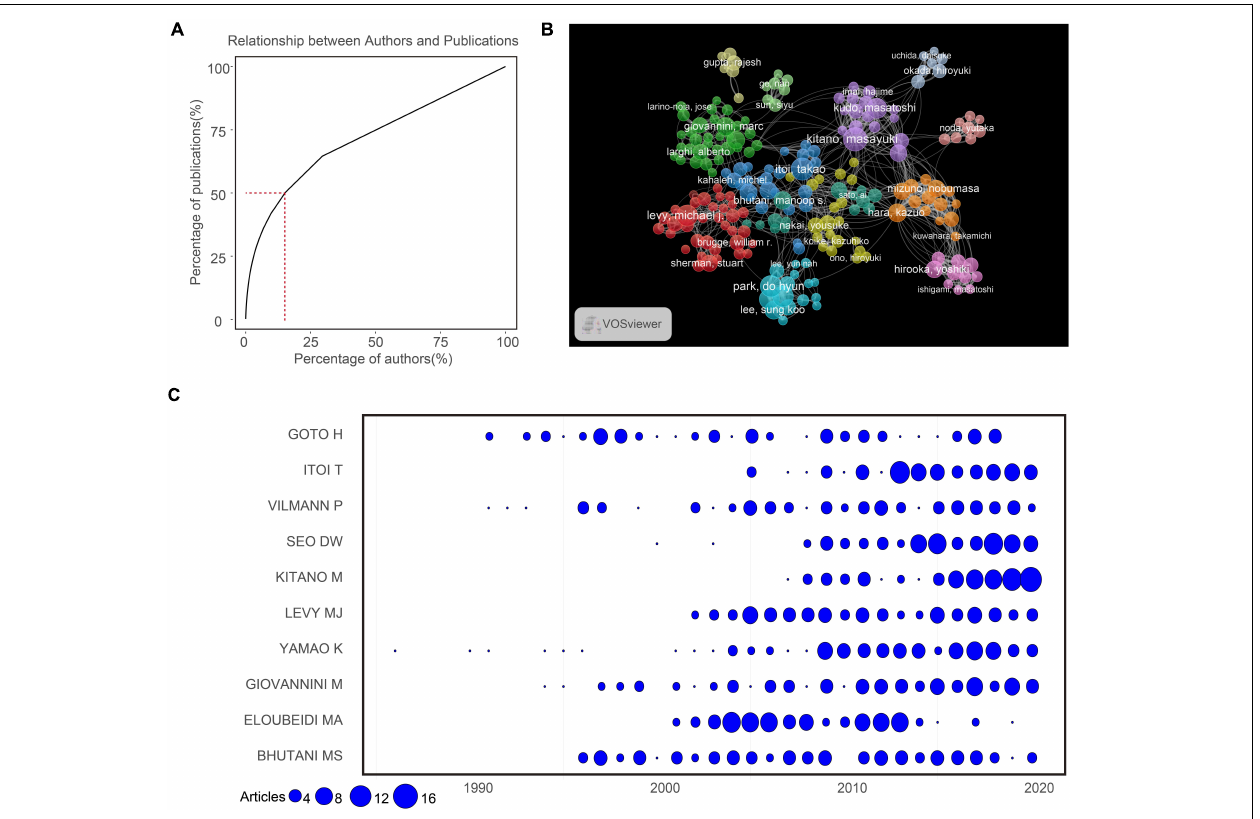
FIGURE 2 | (A) Relationship between the total number of authors and publications. (B) The network map of authors for EUS research. (C) The number of publications for the top 10 productive authors per year.